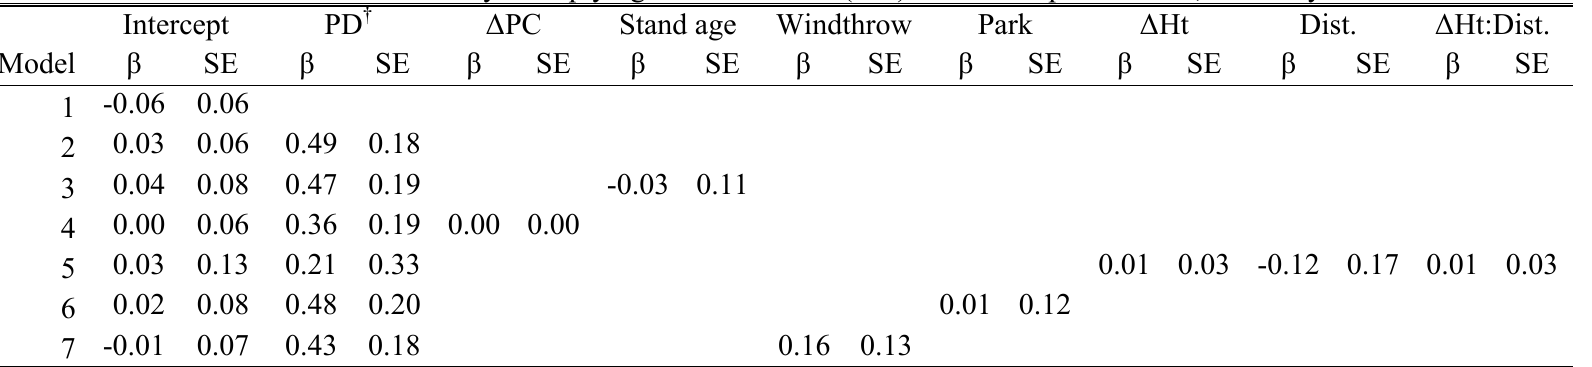
Table A2.8 Parameter estimates for models examining variation in stand-level trends (between circa 1994 and 2014) in abundance Yellow- rumped Warbler in aspen dominated mixedwood forests in central Saskatchewan. 85% Confidence Intervals can be obtained as β ± 1.44* SE. NOTE: Parameter values were rescaled by multiplying with a constant (100) for ease of presentation, divide by 100 to obtain estimates.